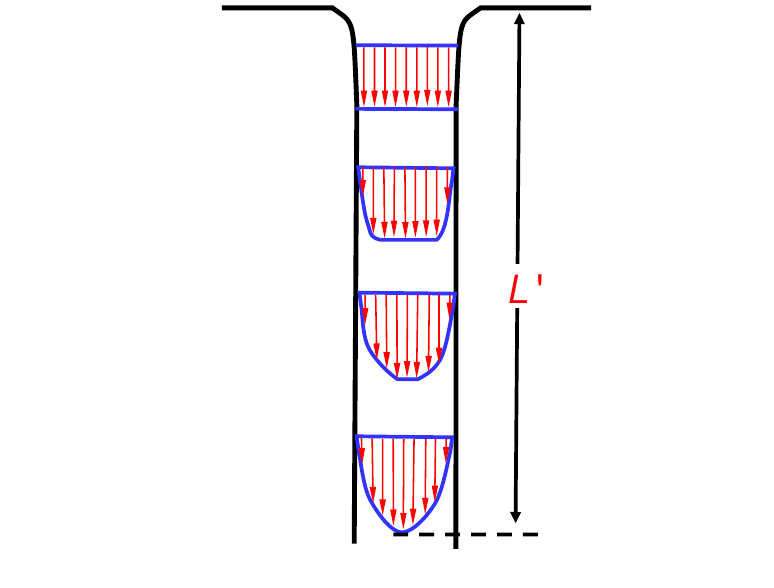
Figure 4. Schematic representation of flow development showing critical length for fully developed laminar